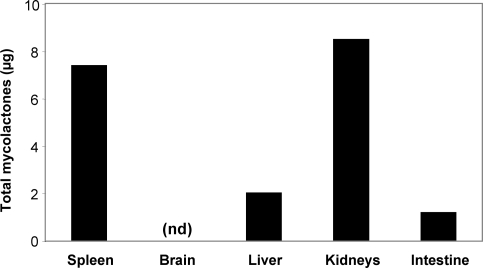

M. ulcerans–produced mycolactone diffuses in internal organs of experimentally infected mice.The distribution of mycolactone is shown in internal organs of mice ten weeks post sc infection with 104
M. ulcerans bacilli. The amount of mycolactone was determined by ESI-LC-MS analysis of acetone-soluble lipid extracts prepared from pools of 5 homogenized organs. Data correspond to the calculated amount of total mycolactones (A/B and C forms) per organ, nd: not detected.